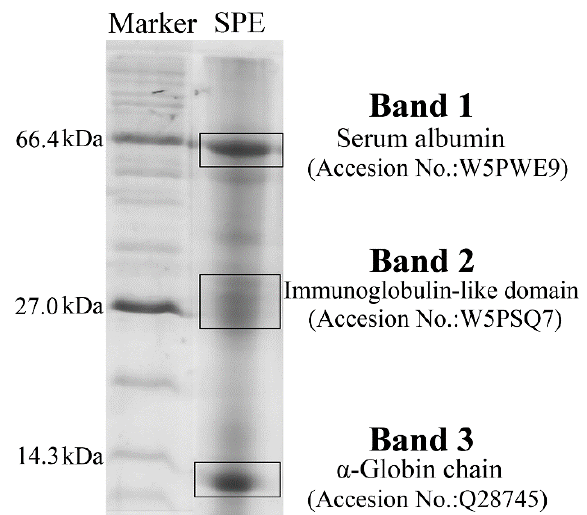
Figure 1. SDS-PAGE profiles and identification of proteins by mass spectrometry in sheep placental extract (SPE). Accession No. is the corresponding numbers of the proteins in UniProt database.